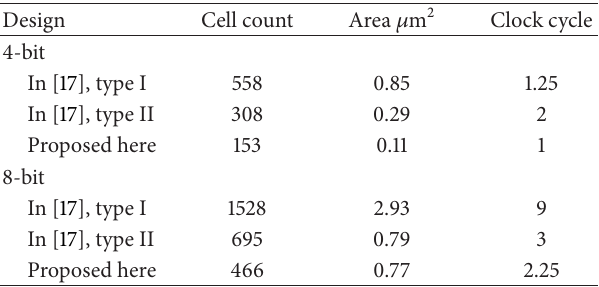
Table 4: Comparison of recent ripple carry adder